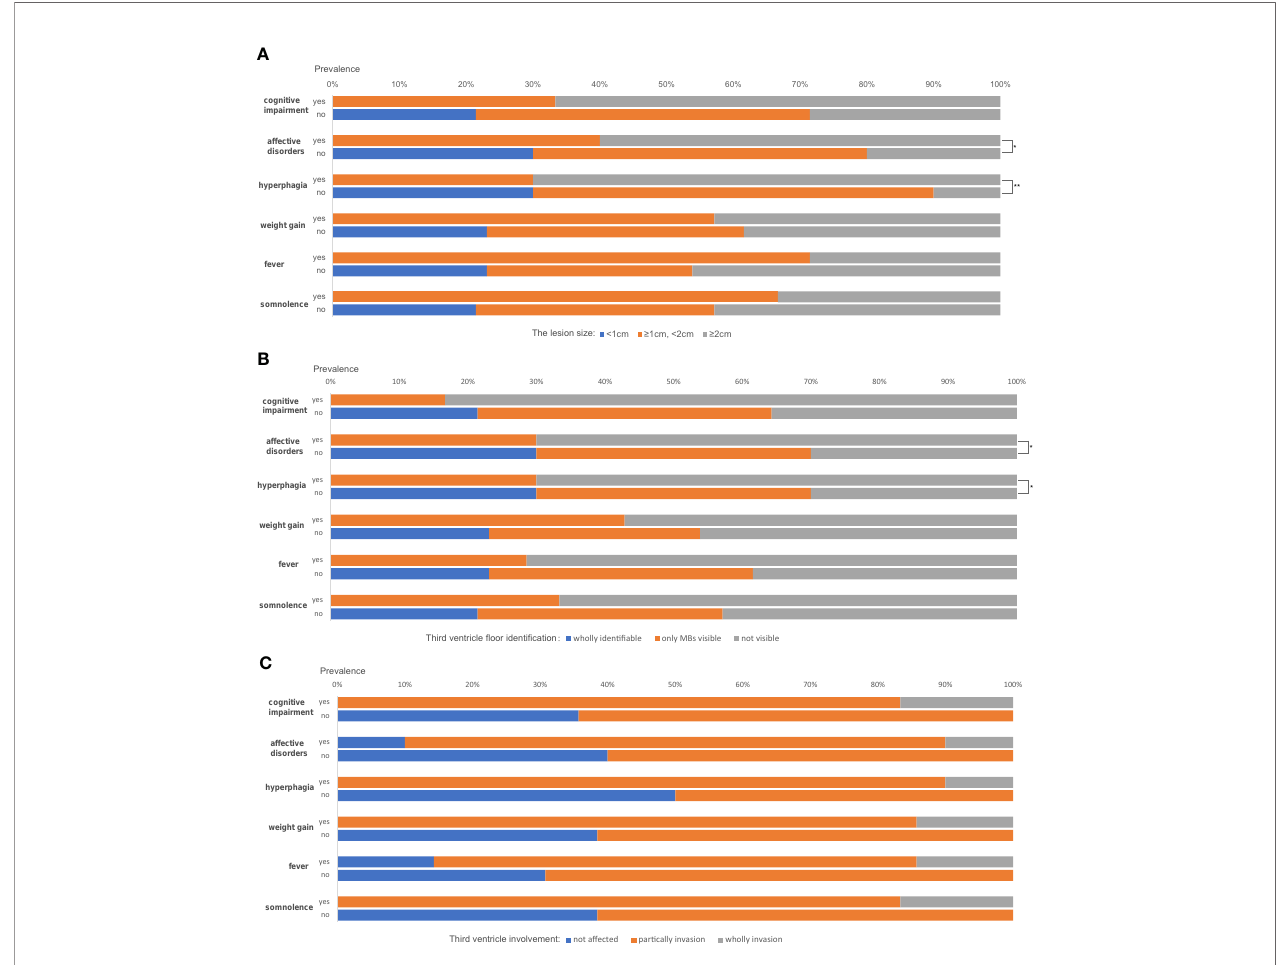
FIGURE 3 | The correlations between complex hypothalamic symptoms and the lesion size (A) , the third ventricle fl oor (TVF) identi fi cation (B) and third ventricle involvement (C) . *P < 0.05, **P <